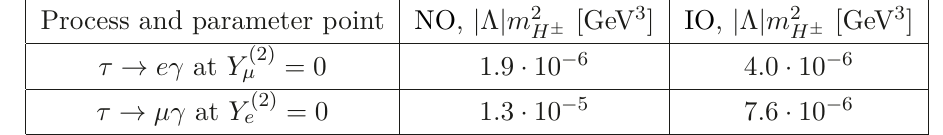
Table 2. Lower bounds on the photon factor, where BR( µ